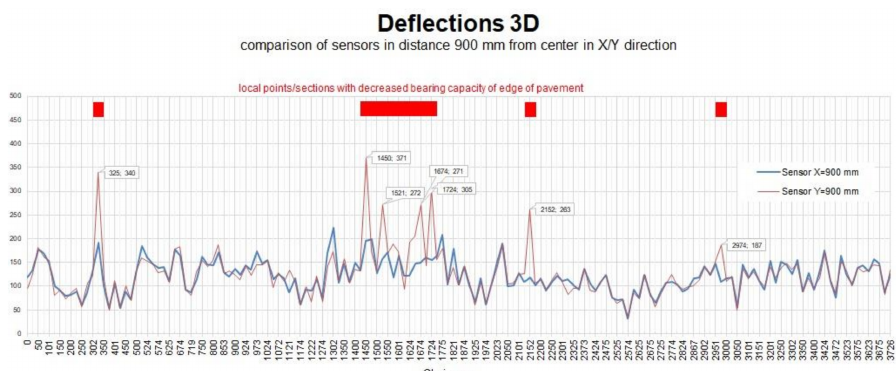
Figure 7. Comparison of sensors in distance 900 mm from center in X/Y